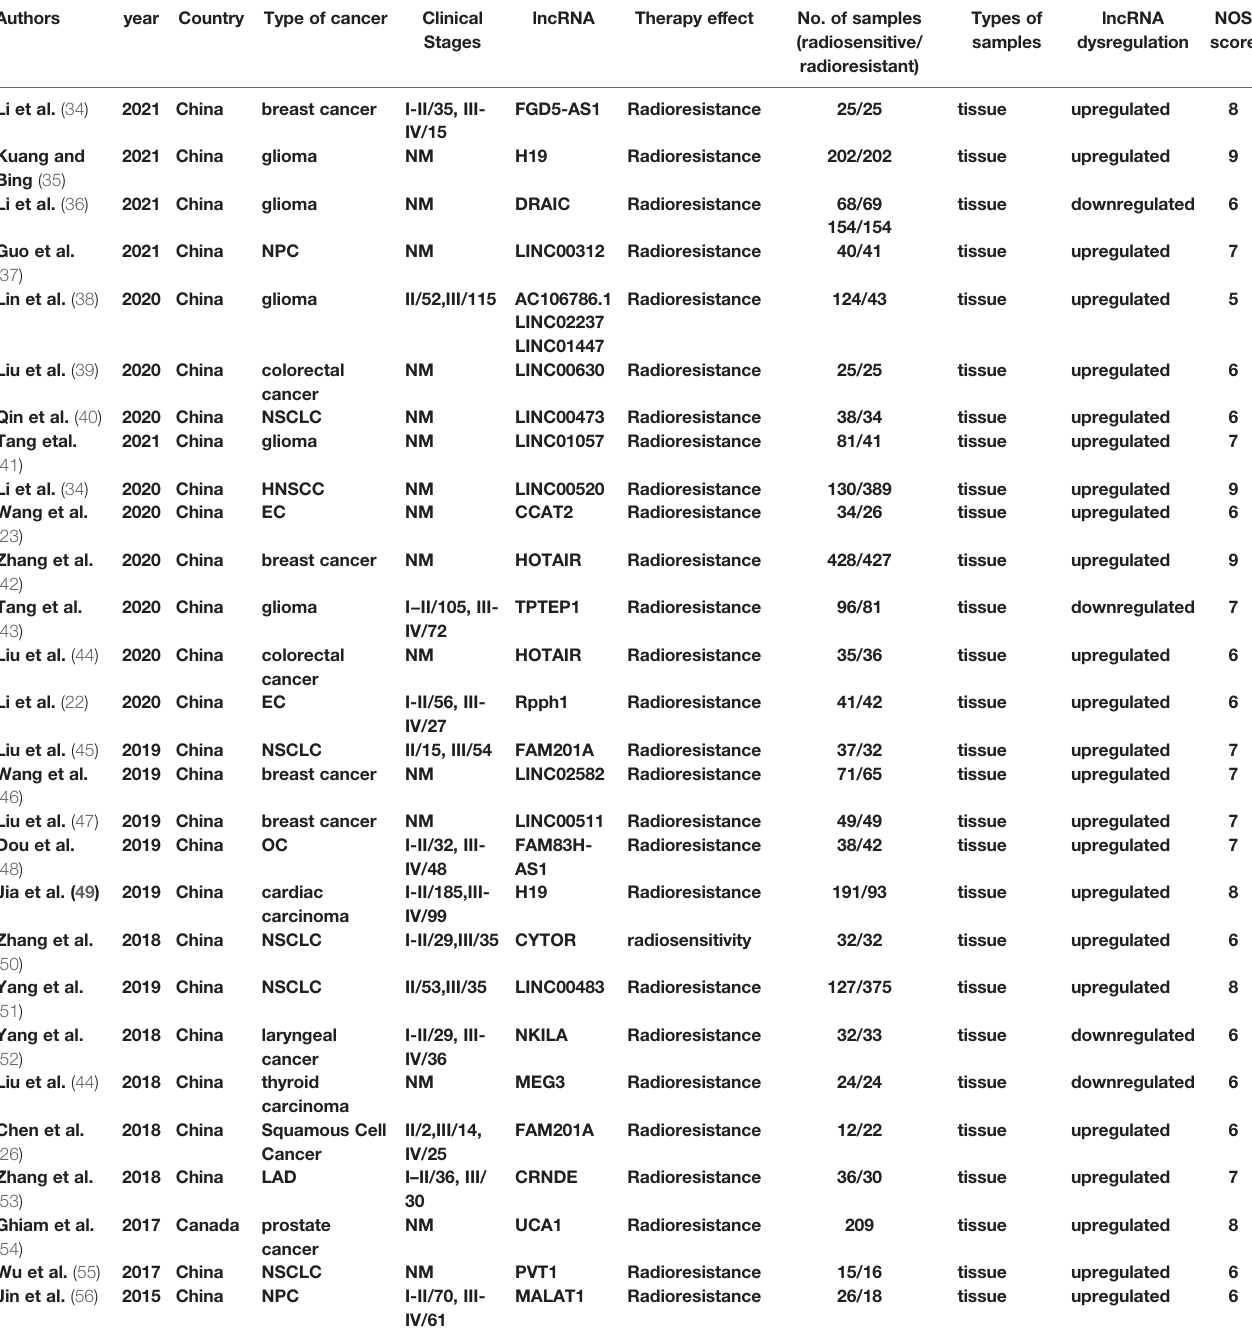
TABLE 1 | Basic characteristics of the included